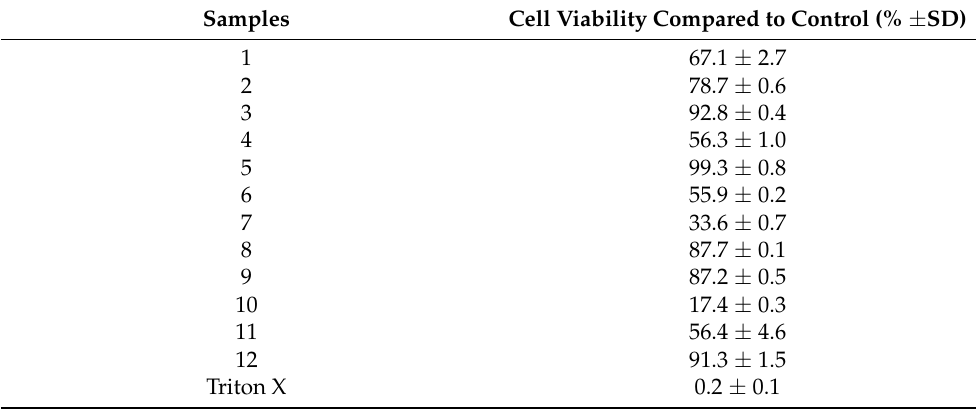
Table 2. Cytotoxicity of the prepared films according to flow cytometry. The experiment was carried out in triplicate (Samples 2, 4, 6, 8, 10, 12 contain CA).